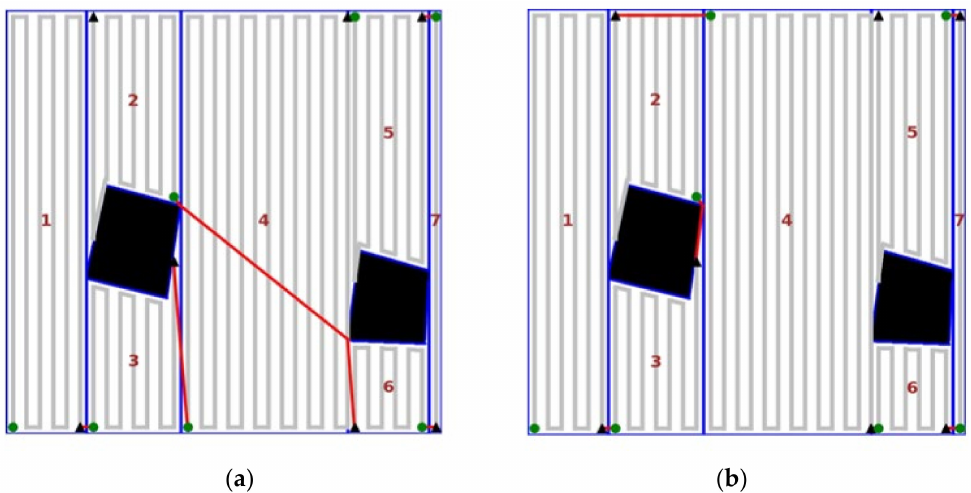
Figure 12. ( a ) Traditional CCPP; ( b ) improved CCPP. In the figure, the green dots represent the starting point of each sub-region and the black triangle represents the finishing point of each region. The red lines are the route connecting sub-regions. Table 8. Geodetic coordinates of Figure 13a. Geodetic Coordinates of Geodetic Coordinates of Geodetic Coordinates of Farmland Area Obstacle 1